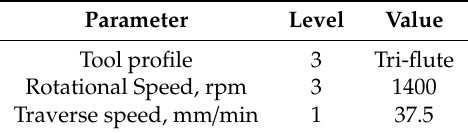
Table 17. Optimum process parameters.